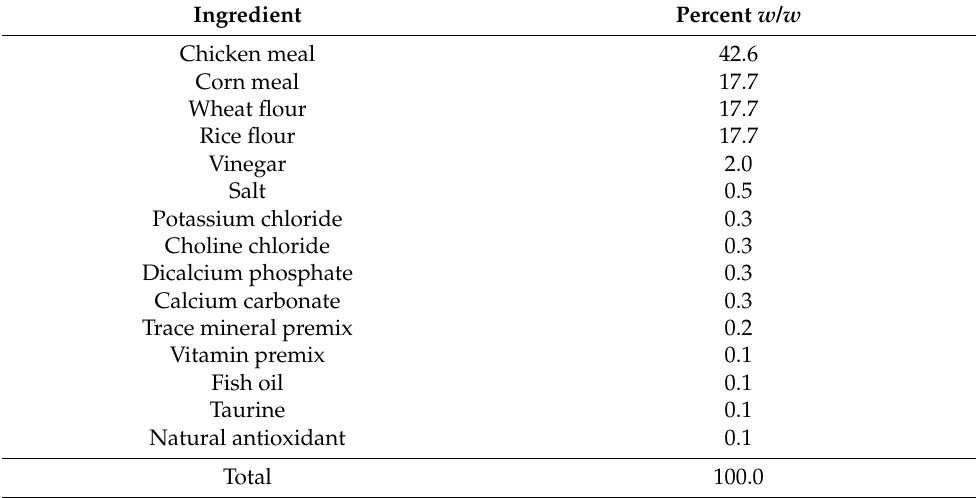
Table 1. Formulation of uncoated dry pet food